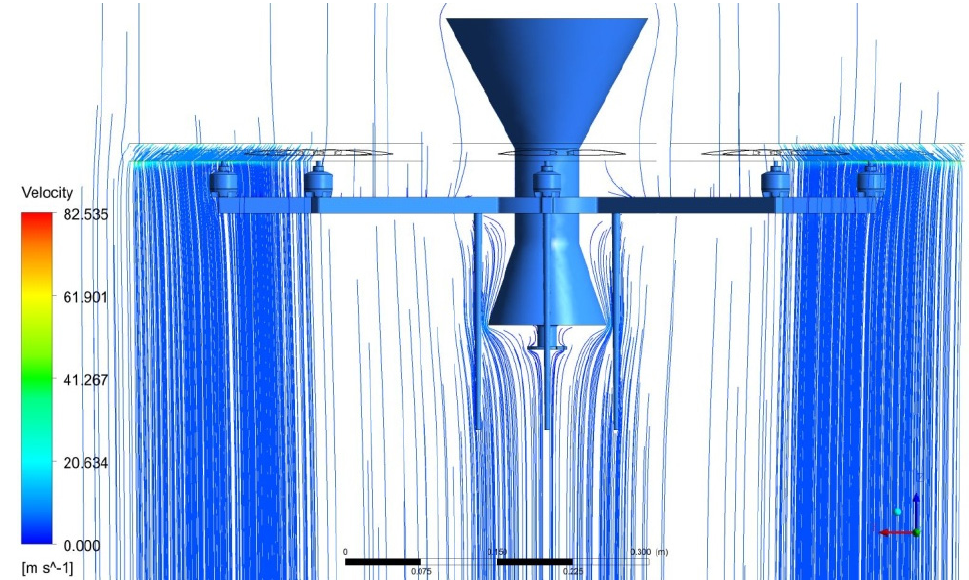
Figure 28. Velocity distributions over the entire fog-clearance drone.